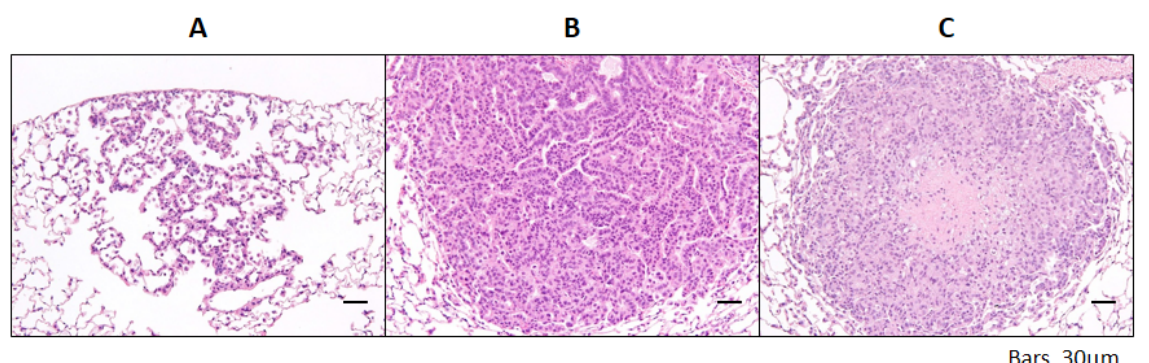
Figure 1. Histopathologic features of representative pulmonary proliferative lesions (hematoxylin and eosin stain). ( A ) bronchioloalveolar hyperplasia; ( B ) adenoma; ( C ) adenocarcinoma. There are numerous hyperplastic alveolar cells with an alveolar structure in bronchioloalveolar hyperplasia while tumor cells without an alveolar structure are present in adenoma. The central area of the adenocarcinoma is necrotic.